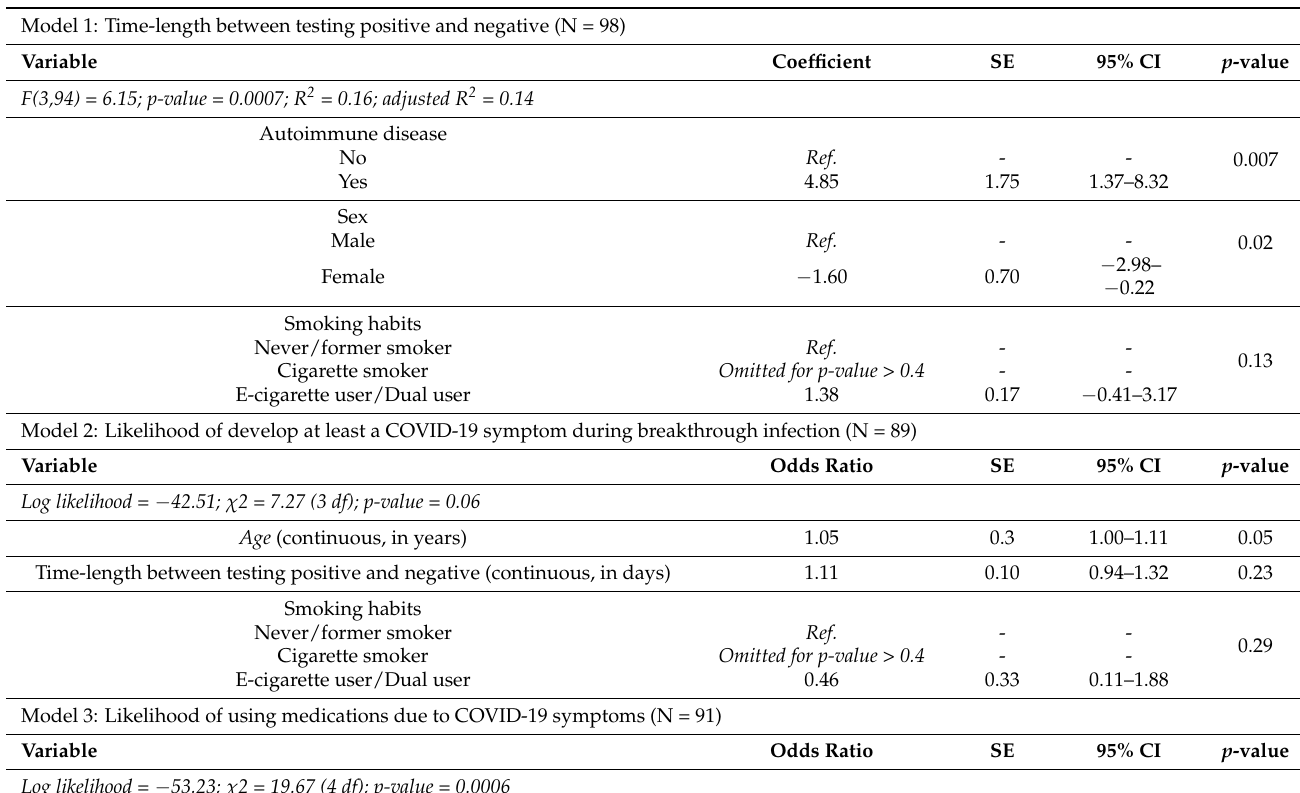
Table 4. Multivariate regression models predicting the characteristics of the breakthrough